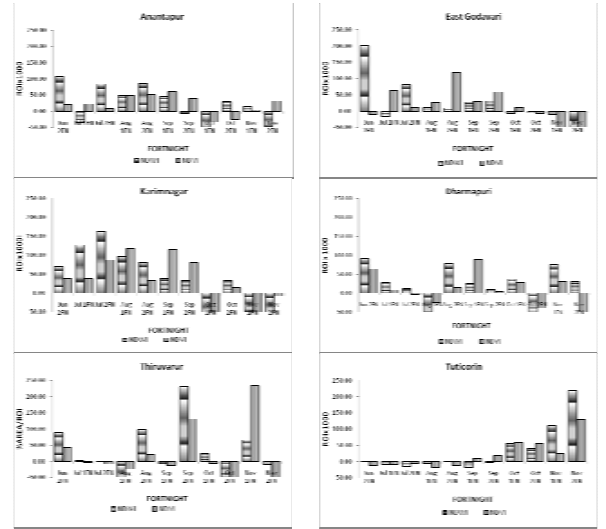
Figure 2: RoI of LSWI and NDVI for few typical districts of AP and TN during